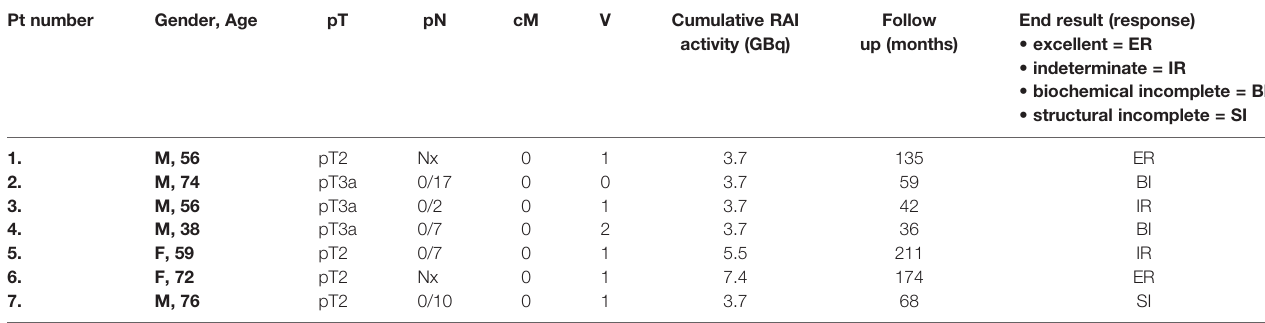
TABLE 2 | Clinic-pathological features of patients undergoing second-line surgery for isolated cervical relapse without distant metastasis.